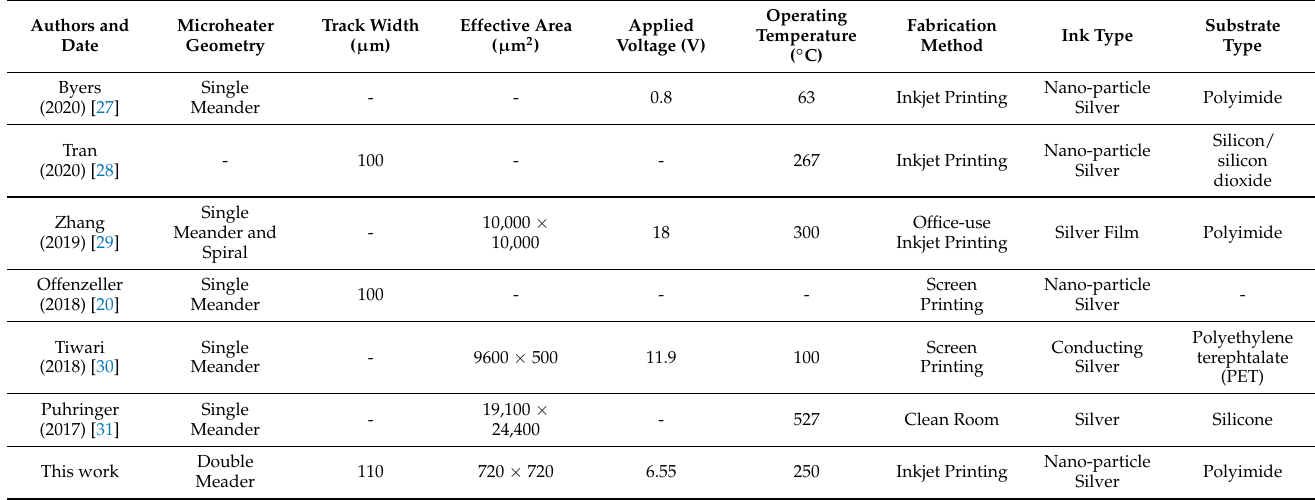
Table 4. Summary of State-of-the-Art Silver